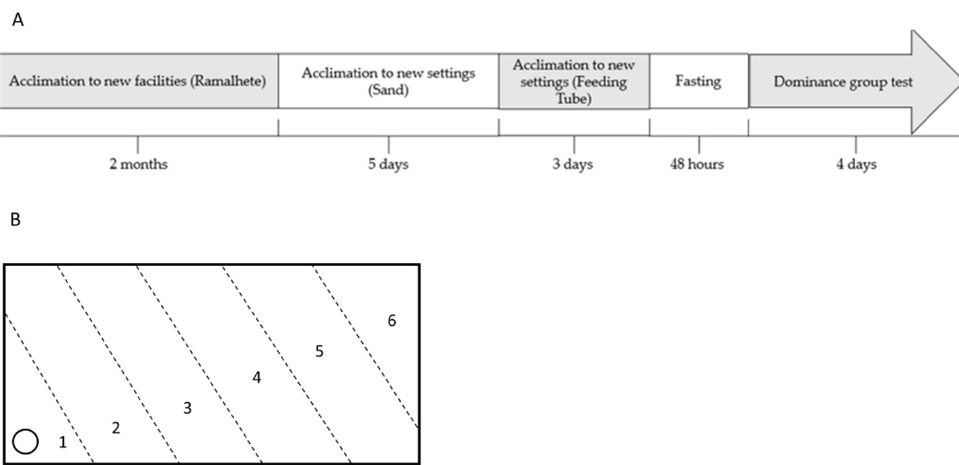
Figure 2. ( A ) Chronogram of the dominance experimental design in Senegalese sole juveniles. ( B ) Scheme of the areas of the different positions used to rank the fish for “Position Before Feeding” (POSITB) and “Position After Feeding” (POSITA) behaviours in the dominance test. Different position areas (1–6) are shown by dashed lines. Circle: The feeding tube consisted of a PVC tube to deliver the food (adapted from Fatsini et al.